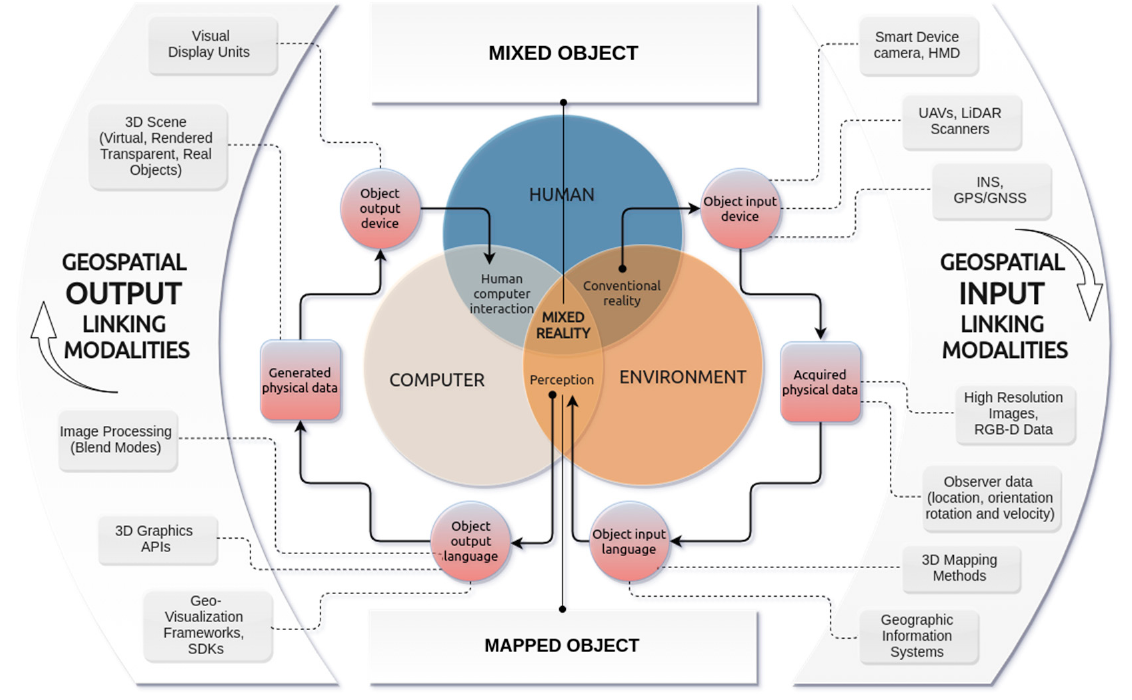
Figure 6. Our approach for the MR ecosystem.